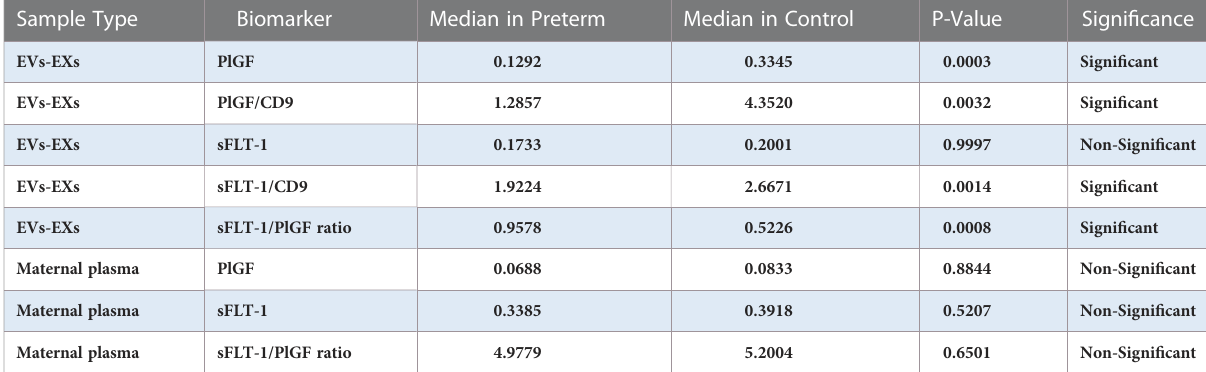
TABLE 2 Quantitative measurement of sFLT-1 and